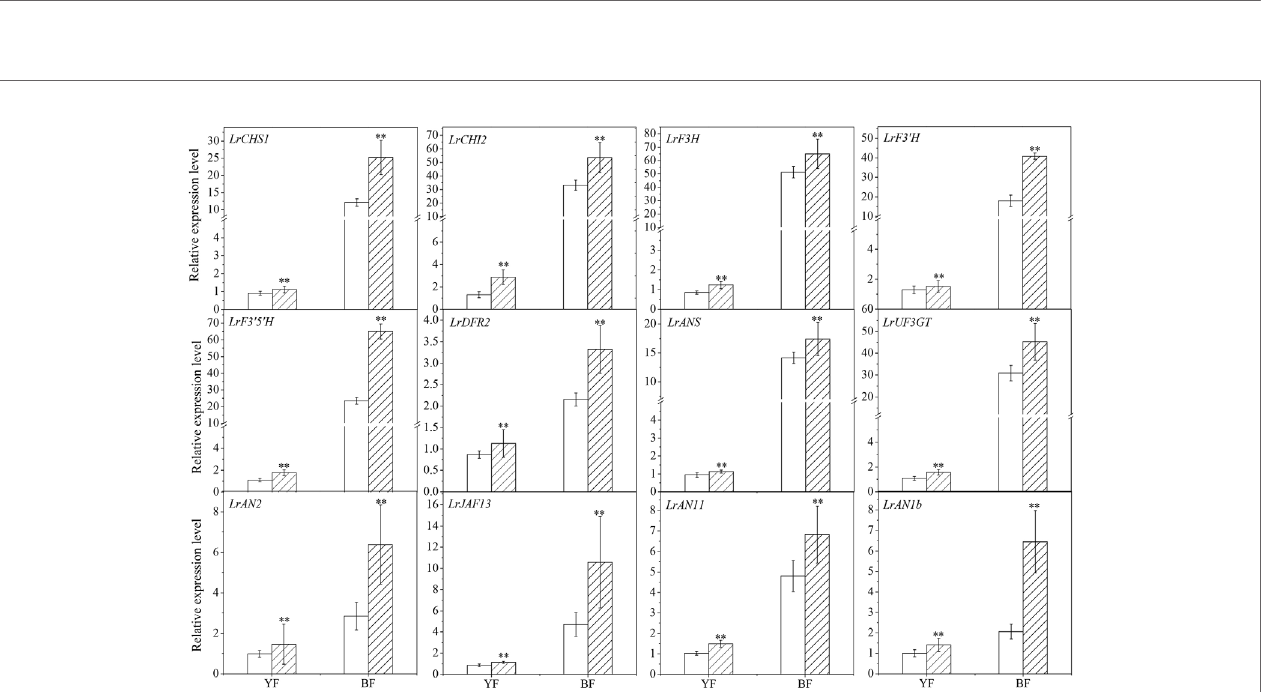
FIGURE 6 | Effect of virus-induced LbNR gene silencing on anthocyanin biosynthesis-related gene expression in Lycium fruits. Transcript levels of LrCHS1 , LrCHI2 , LrF3H , LrF3 ′ H , LrF3 ′ 5 ′ H , LrDFR2 , LrANS , and LrUF3GT , belonging to the structural genes, and transcript levels of LrAN2 , LrJAF13, LrAN11 , and LrAN1b , belonging to the MYB – bHLH – WD40 transcription factors, were shown. The gene expression differences between the two species were compared using YF (injected with empty vector) as the control for calculating the relative expression levels of the indicated genes. The data show the means ± SDs (n = 3). The asterisks on the bars for the same species indicate signi fi cant differences between the treatments. “ ** ” indicates p < 0.01.